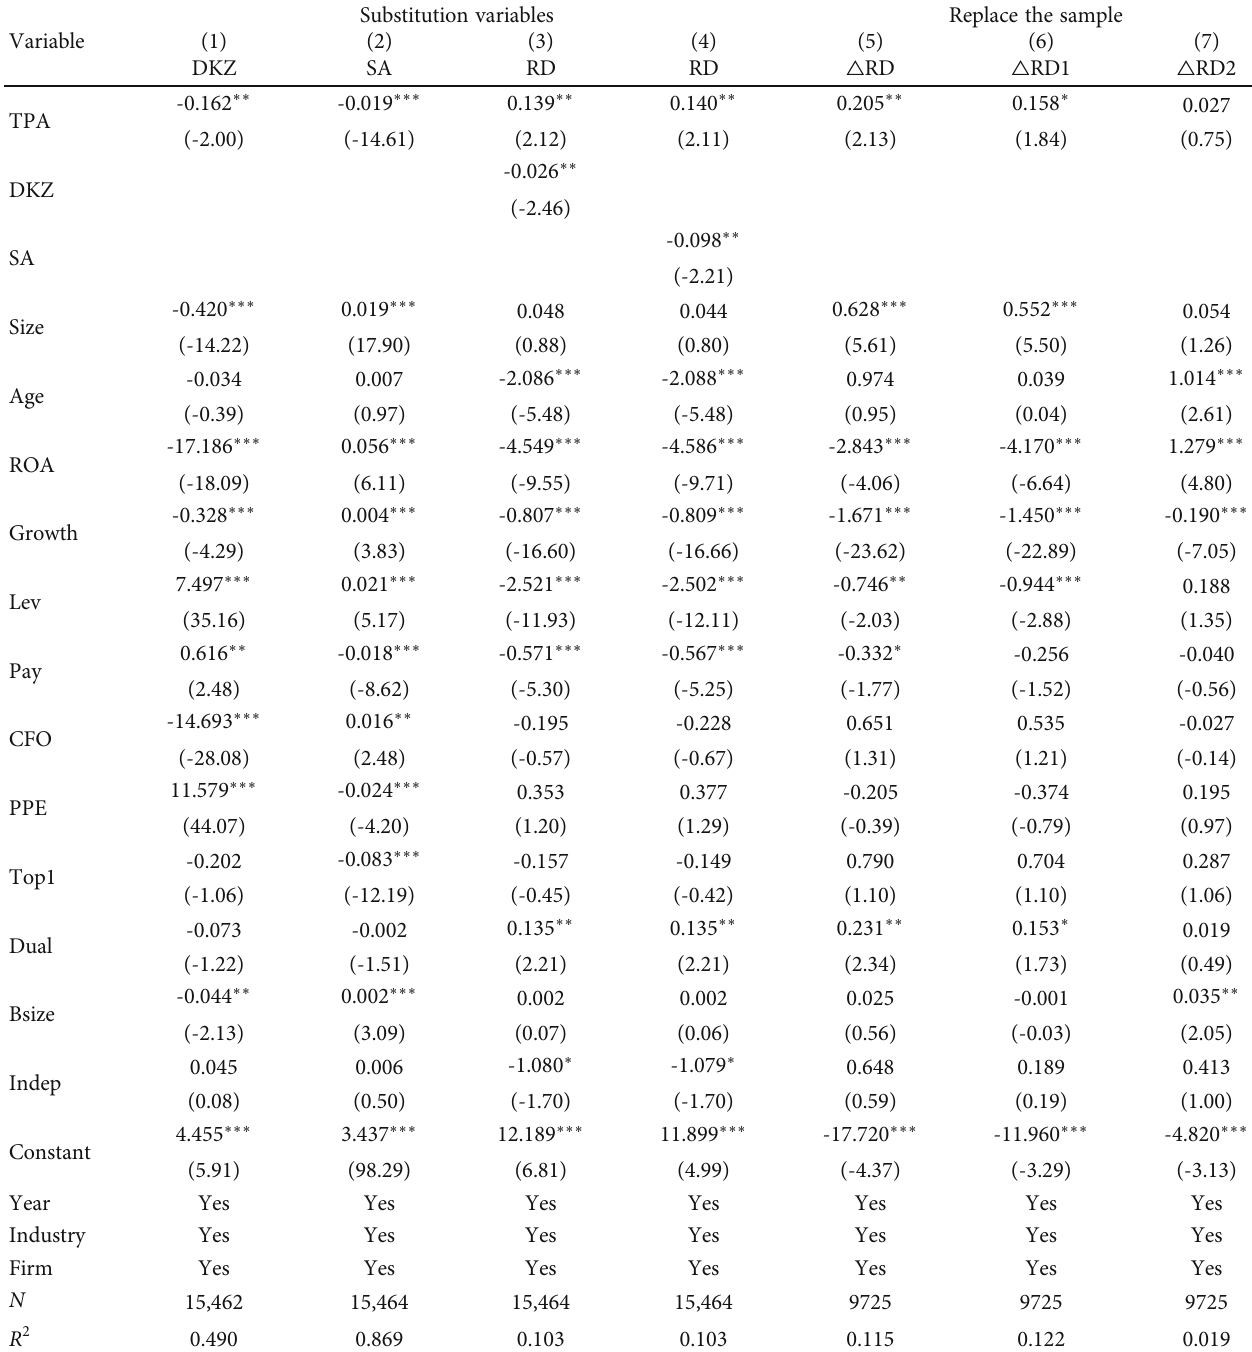
Table 8: Robustness test of substitution